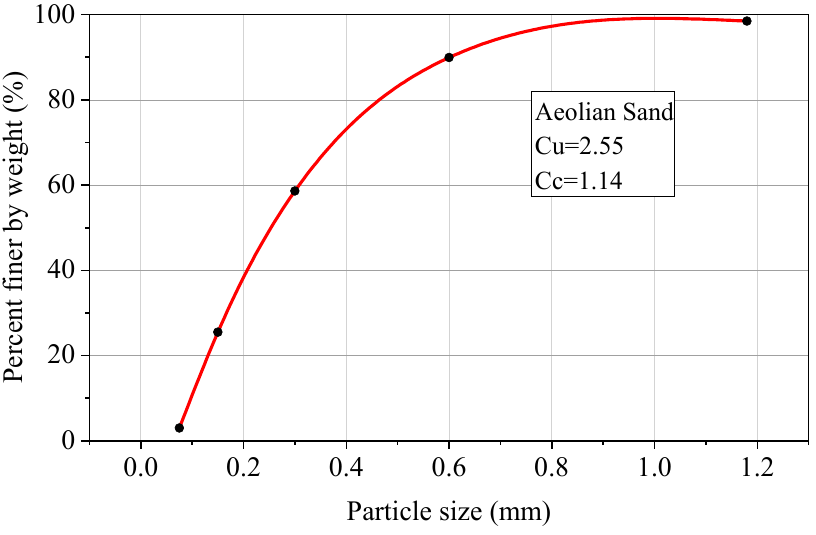
Figure 1. Particle grading curve.